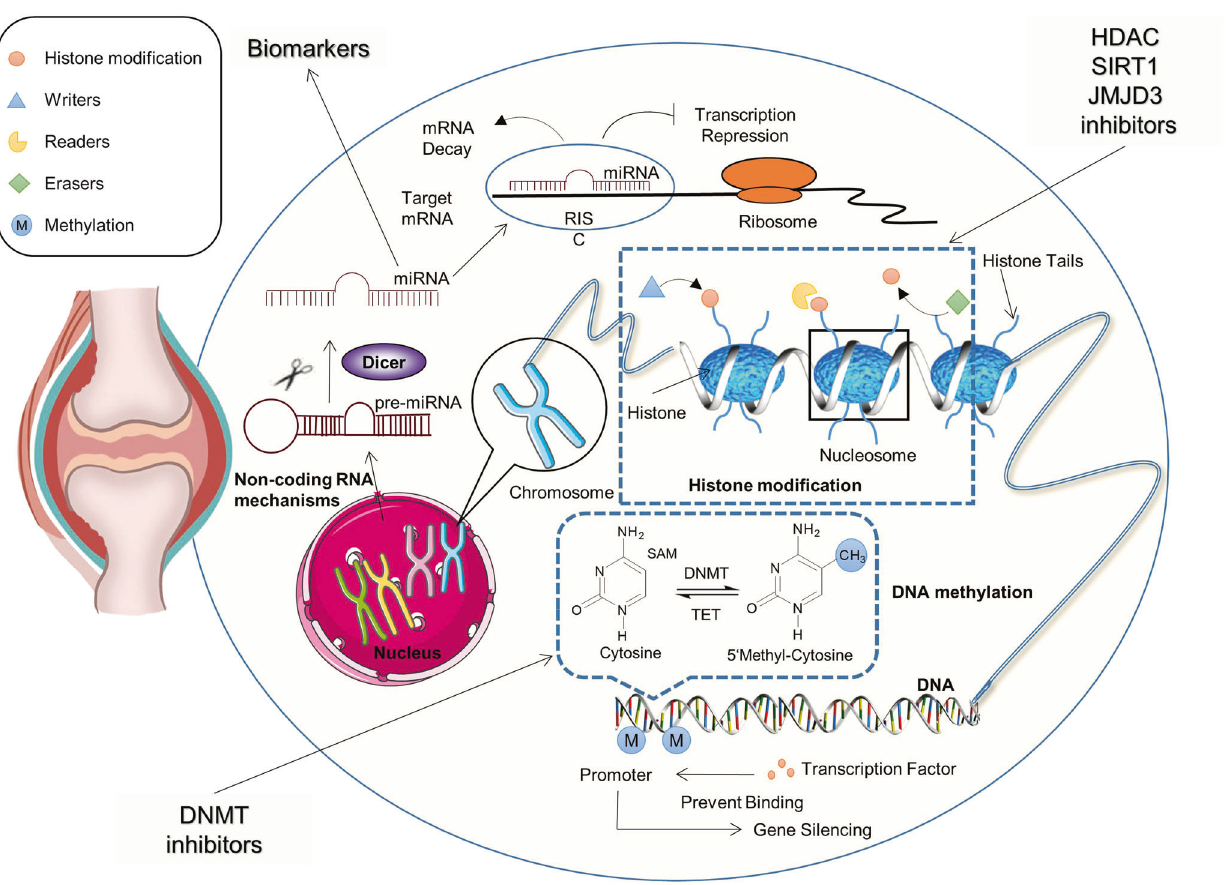
Fig. 6 Epigenetic modi fi cations and rheumatoid arthritis. DNA methylation, histone modi fi cations, and-coding RNA mechanisms are often involved in the development of